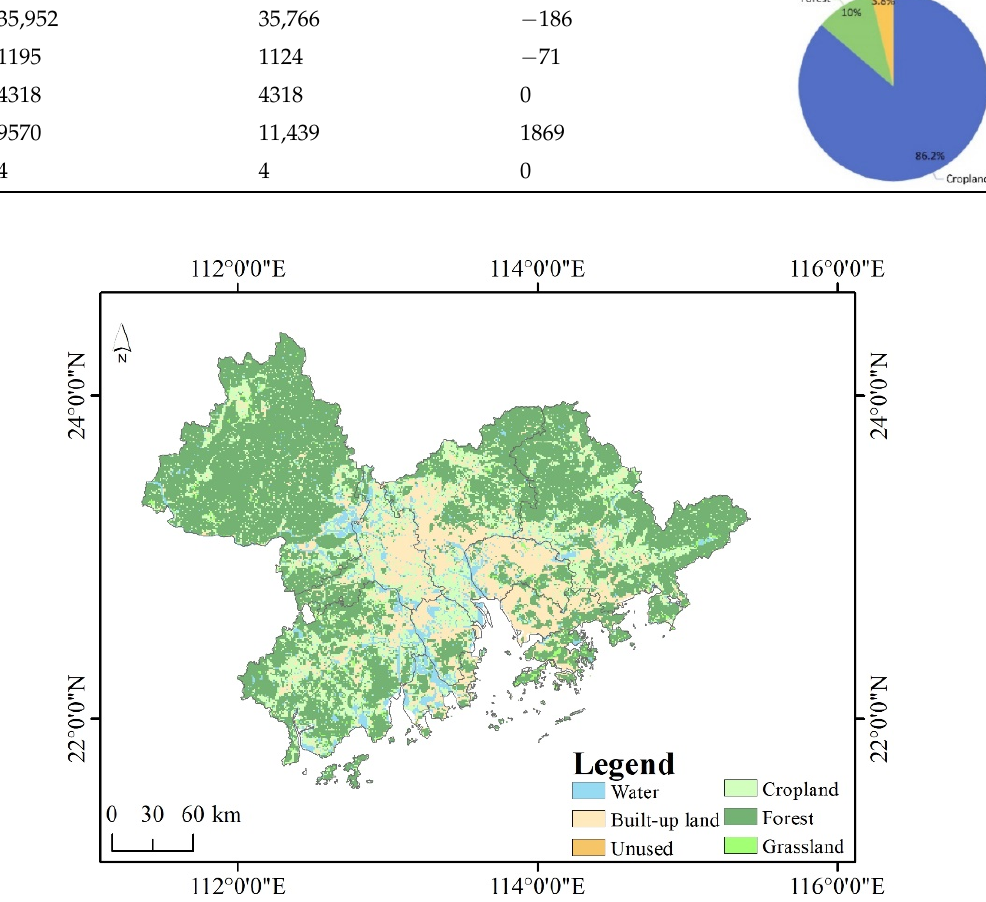
Figure 10. The optimal spatial pa tt ern in 2030.